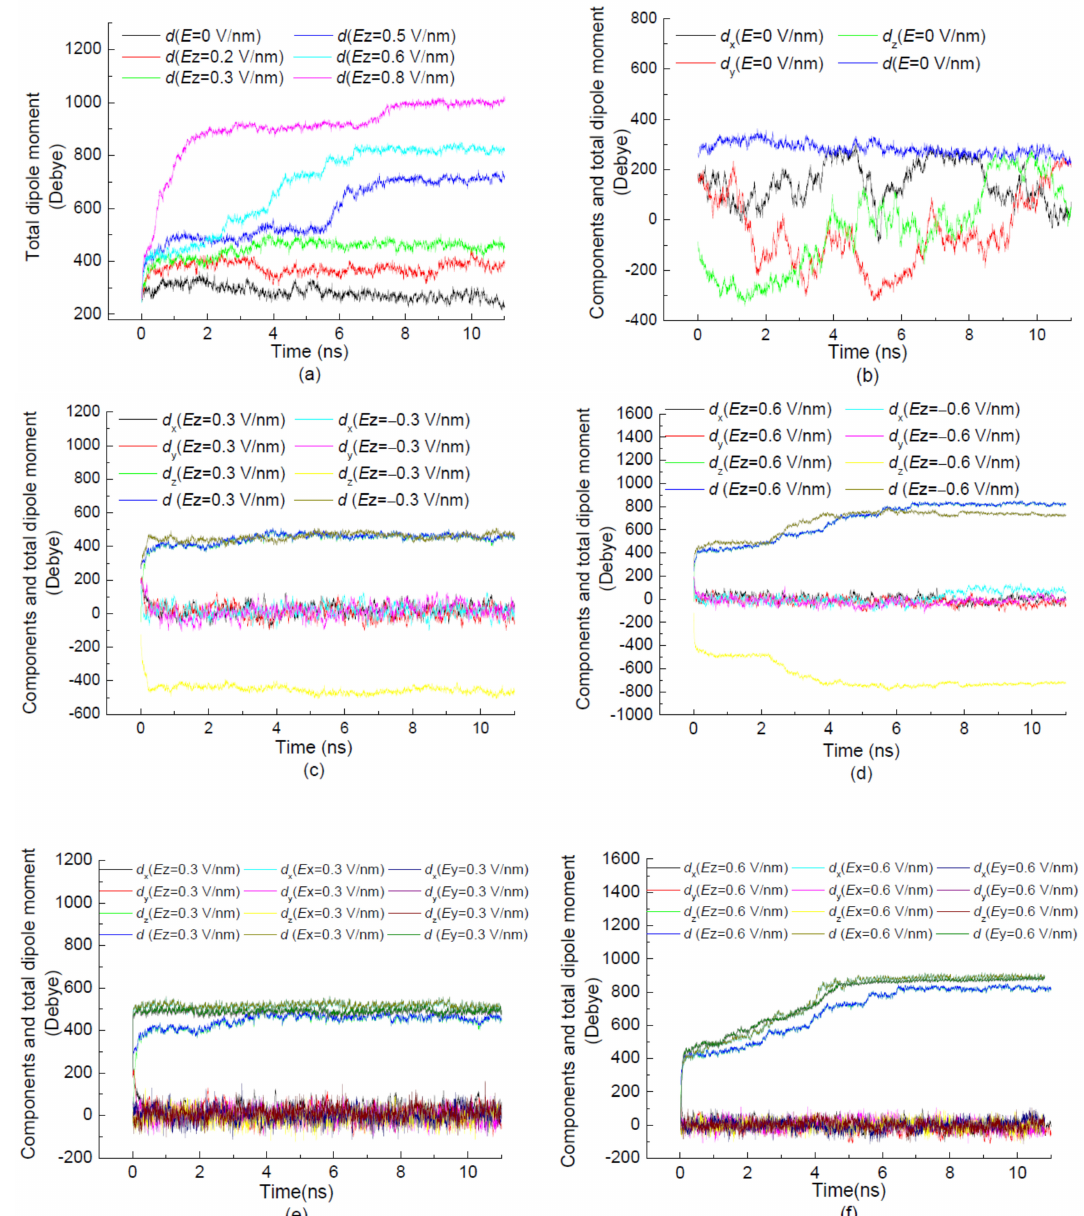
Figure 5. (Color online) Time evolution of total dipole moment of the protein 1BBL exposed in the electric fields along the z -direction with different strengths ( a ), and three components of the dipole moment in the condition of electric strength ( b ) E = 0 V/nm, ( c ) Ez = ± 0.3 V/nm, ( d ) Ez = ± 0.6 V/nm, ( e ) Ex,y,z = 0.3 V/nm, and ( f ) Ex,y,z = 0.6 V/nm,